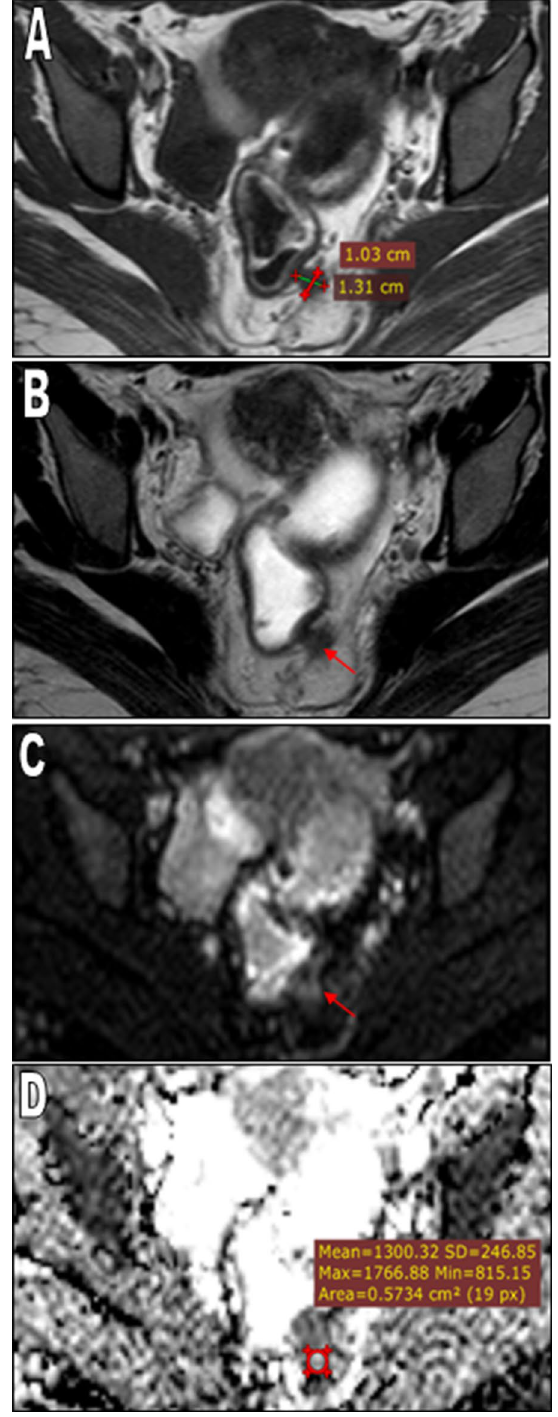
Fig. 3 MRI for a 31-year-old female patient with pathologically proven rectal adenocarcinoma presented clinically with tenesmus. A Axial T1 WI and B Axial T2 WI showed enlarged left peri-rectal lymph node measuring about 13 10 mm at maximum axial dimensions, × eliciting intermediate T1 and T2 signals, has an oval configuration with irregular borders, morphologically it is considered to be suspicious lymph node. C DWI and D ADC map showed restricted diffusion; with the predominant bright areas on DWI corresponding to high signal areas on the ADC map. ADC